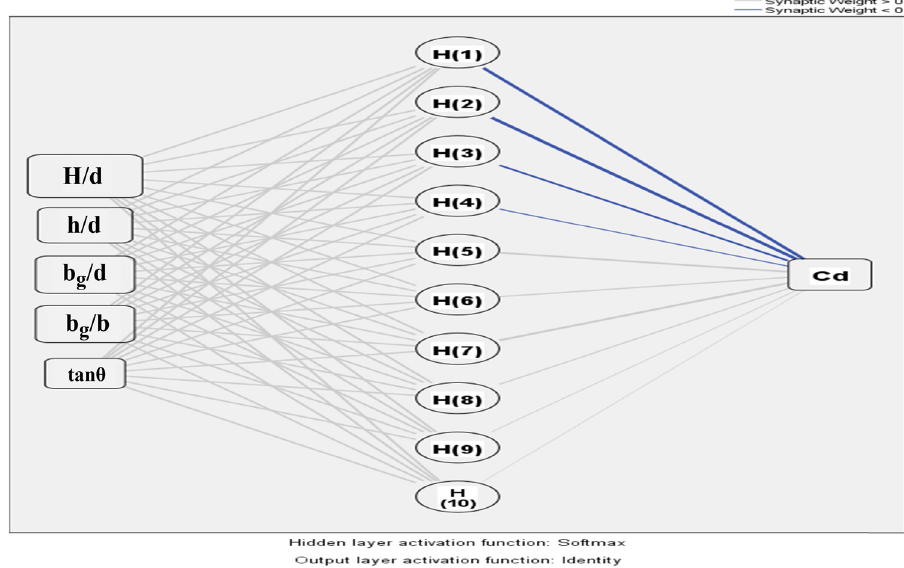
Figure 3: The development of RBF of ANN model by SPSS V24